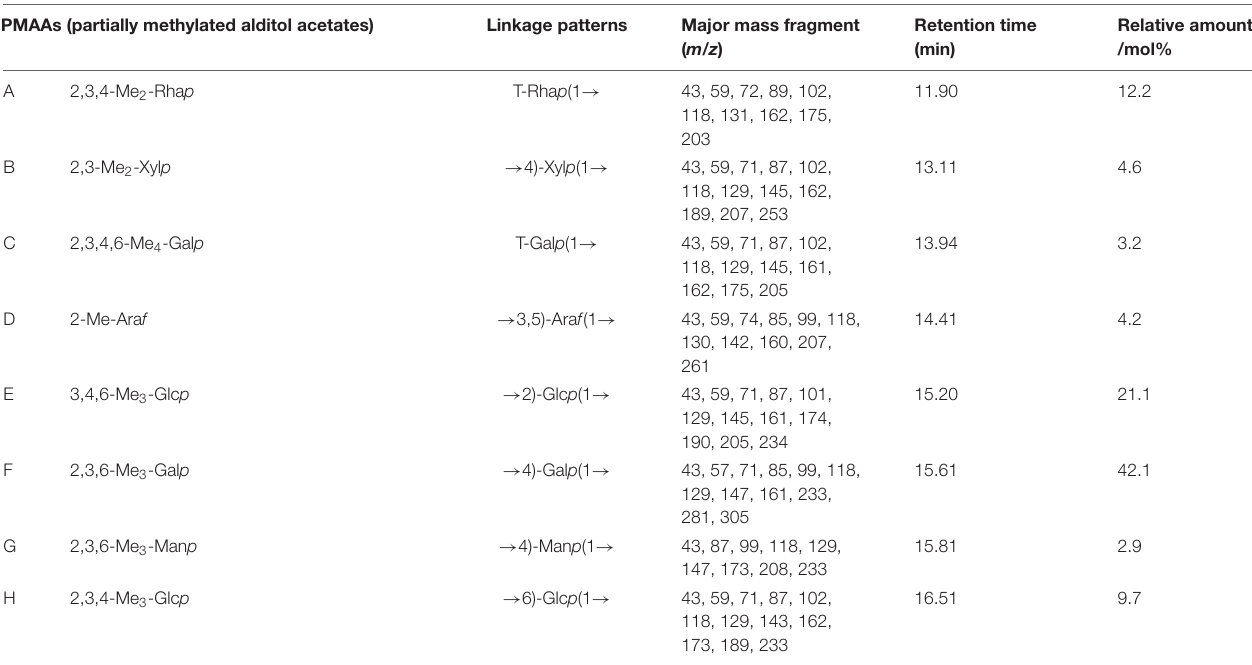
TABLE 2 | Methylation analysis result of